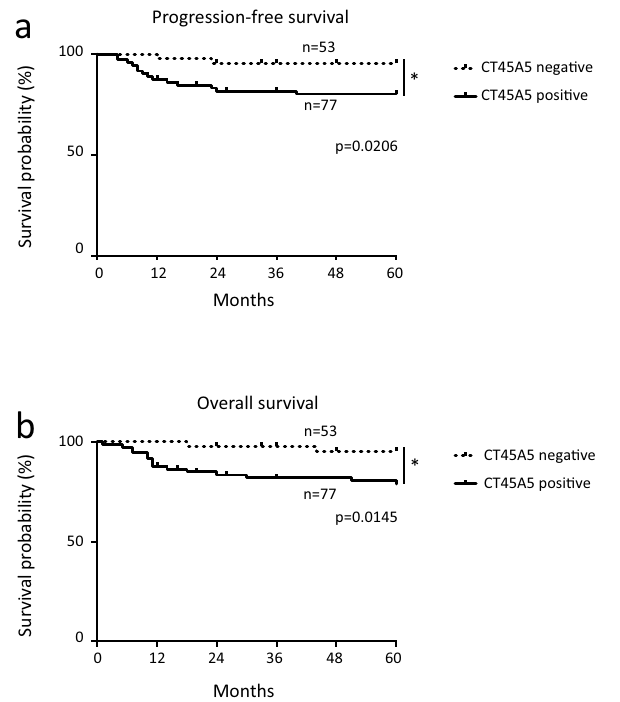
Figure 6. Prognosis analysis of CT45A5 in endometrial cancer tissue was evaluated by the Allred scoring system in which two categories (stain intensity and stain pattern) were evaluated as described in Supplementary Table S2. ( a ) Progression-free survival curves were plotted using the Kaplan–Meier method and compared using the log-rank test. ( p = 0.0206). ( b ) Overall survival curves were plotted using the Kaplan–Meier method and compared using the long-rank test. ( p =